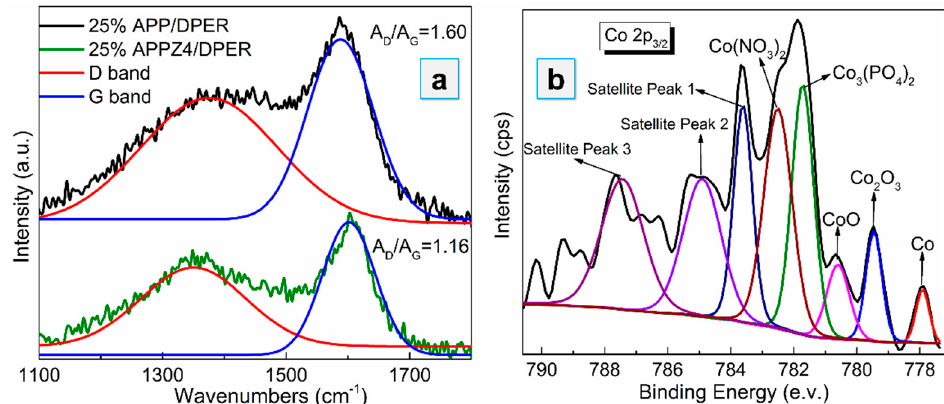
Figure 11. Surface char analysis: ( a ) Raman analysis of 25% APP/DPER and 25% APPZ4/DPER; ( b ) fitting curves of XPS Co 2p 3/2 spectrum of 25% APPZ4/DPER.